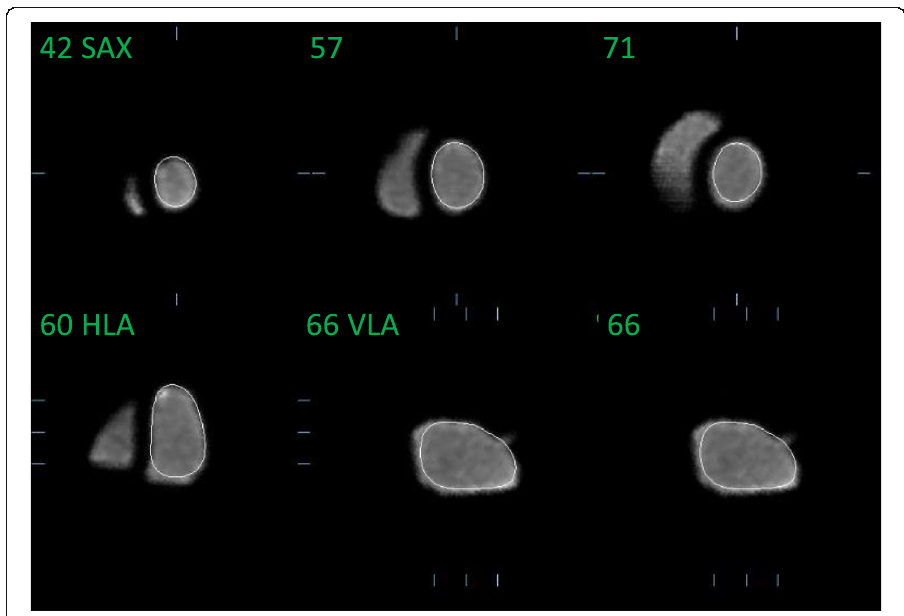
Fig. 6 Automated segmentation with quantitative blood pool SPECT (QBS) of native 3D PET/CT images at end-diastole. The lines indicate the imprecise ventricle edges that were determined by this automated segmentation